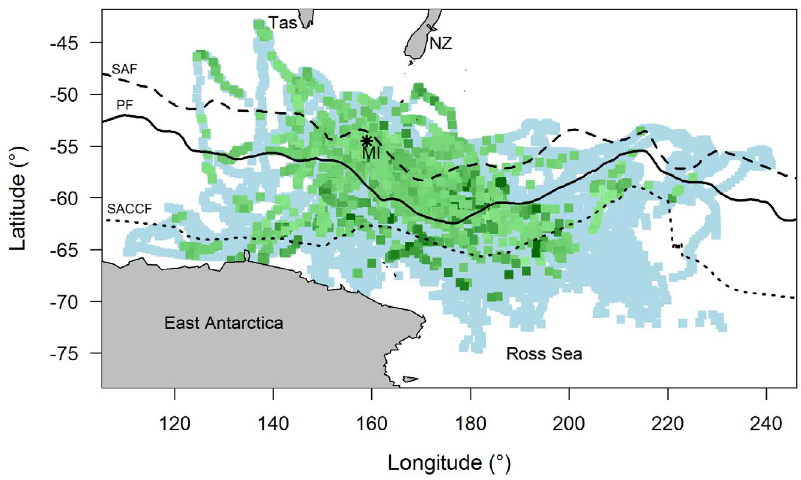
Figure 3. Noon locations for all seals with and without concurrent chl-a . Includes locations during post-moult and post-breeding foraging trips collectively (light blue), and of these, all that correspond with chl-a (green). Scale of chl-a values denoted by grading from light green (0.03 mg m 2 3 ) to dark green (2.48 mg m 2 3 ). Map shows the bottom of Tasmania (Tas) and New Zealand (NZ) and the coast of East Antarctica and Ross Sea (bottom). The black asterisk shows Macquarie Island (MI). Lines represent the historical mean positions of the Sub-Antarctic Front (SAF - dashed), Polar Front (PF - solid) and Southern Antarctic Circumpolar Current Front (SACCF - dotted).